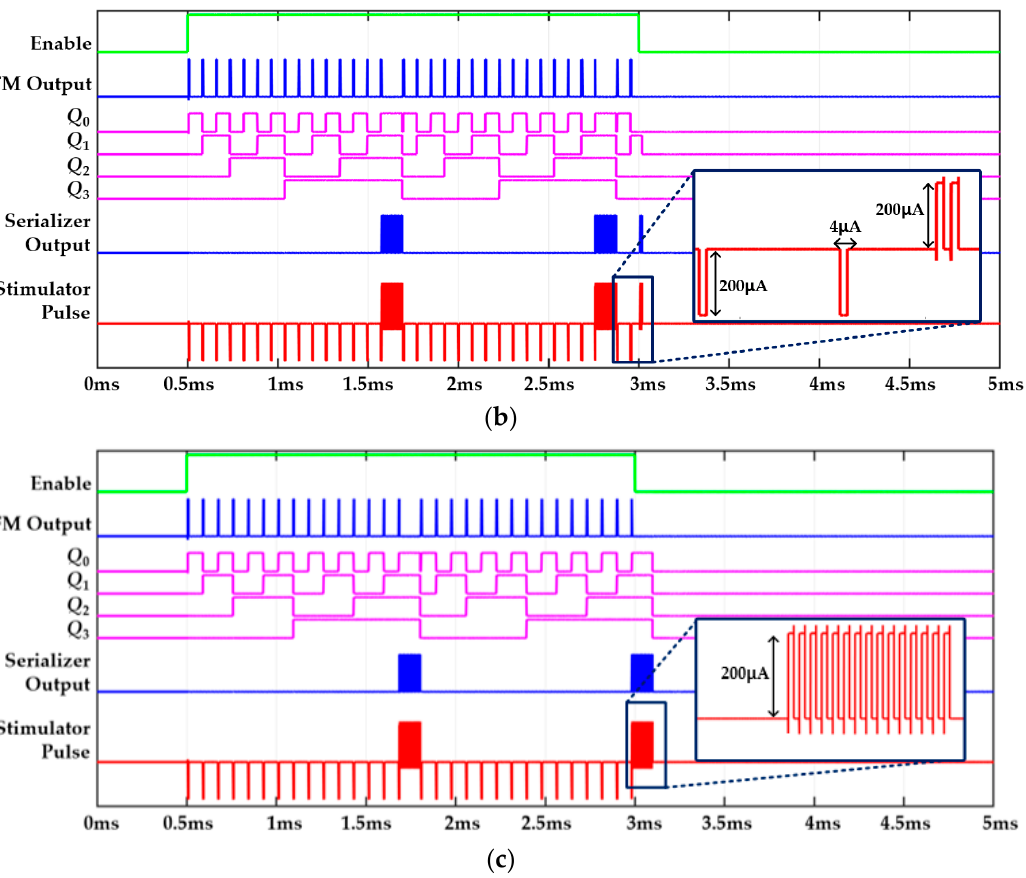
Figure 9. Observed transient output waveforms at each block. ( a ) Five pulses when the incoming light intensity is weak. ( b , c ) Two different cases when incoming light is strong ( c ).